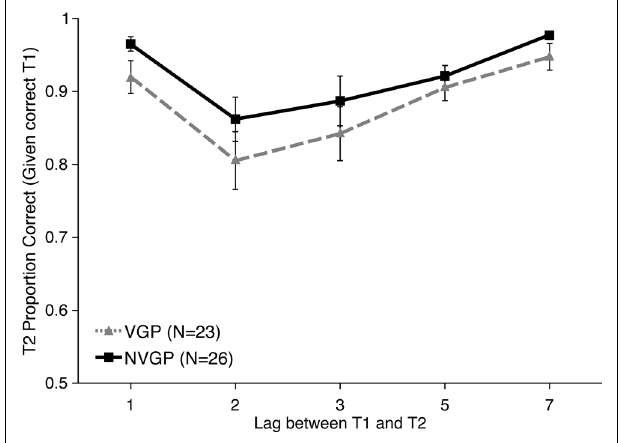
FIGURE 4 | Results from Experiment 2 showing second target accuracy for trials on which the first target was correctly identified as a function of inter-target Lag. nVGPs non-significantly outperformed VGPs at all lags. Error bars represent standard error of the